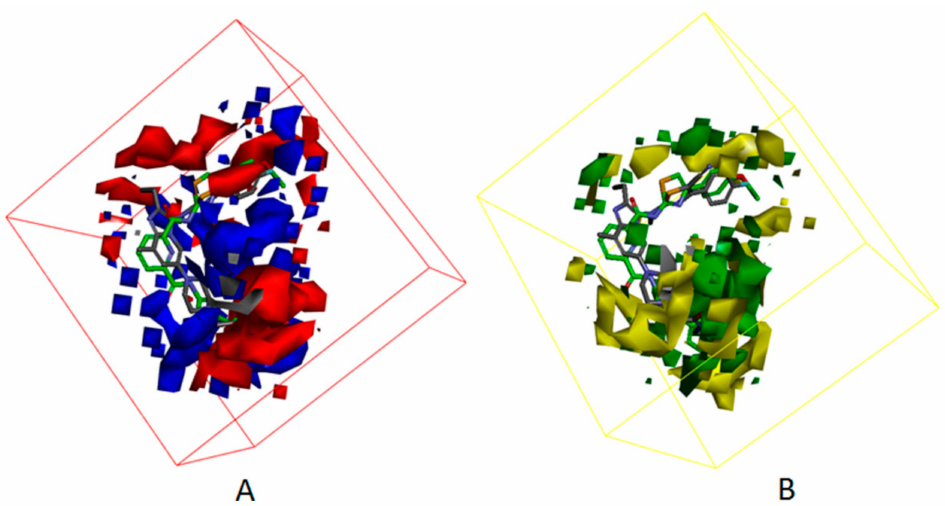
Figure 12. The mappings of cpd7 with isosurface-EP (–, red; + , blue) ( A ), isosurface-VMD (–, yellow; + , green) ( B ) grids. cpd7 is presented in green stick form. Compound 7NB complexed with autotaxin is also shown for comparison (in gray stick